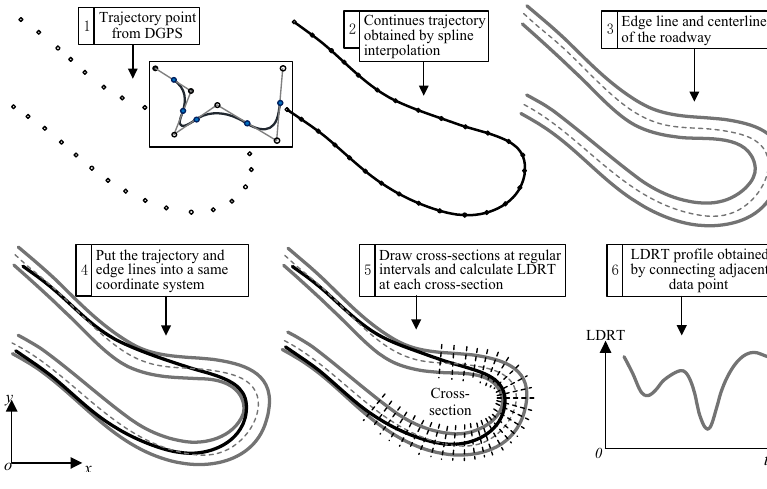
Fig. 4 Obtaining continuous vehicle trajectory and determining the lateral deviation rate of trajectory (LDRT)